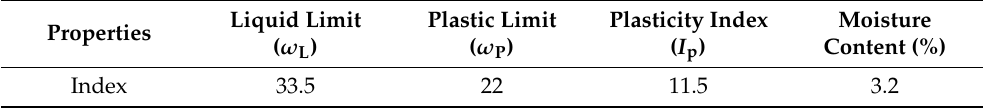
Table 3. Properties of the clay samples.